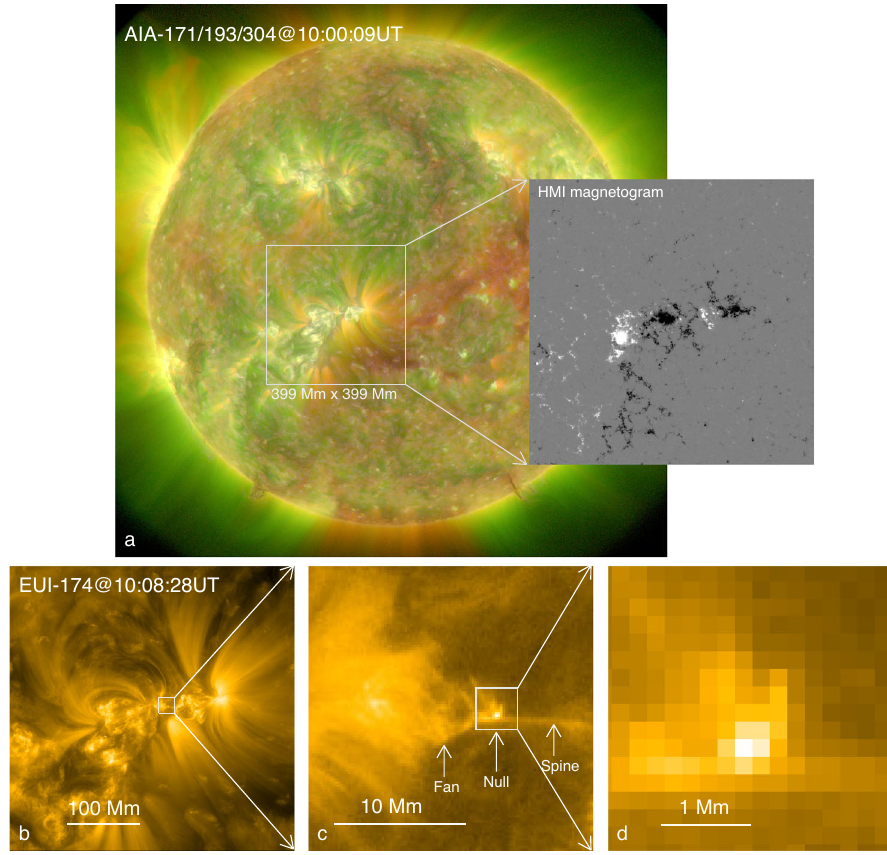
Fig. 1 | Overview of observations. a Composite of the AIA 171 Å , 193 Å , and 304 Å passbandsshowingthefulldiskEUVimageoftheSunat10:00UTon2022March3 overlaid by the simultaneous HMI LOS magnetogram for the same FOV of the EUI/ HRI (white box) with the positive (negative) polarity in white (black). b The EUI/ HRI EUV 174 Å fullFOVimagedisplayingthe fi nestructureofNOAA12957. c Zoom-in ofpartofHRI EUV FOV(whiteboxin b )showingafan-likebrightstructuresuggesting